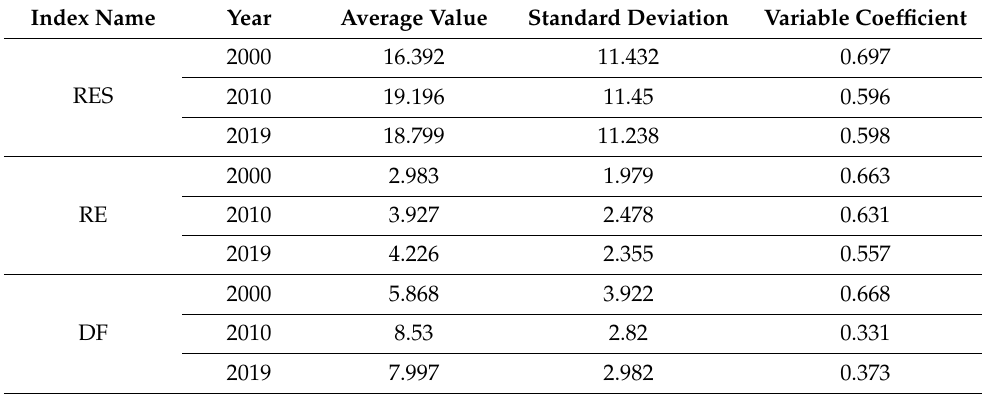
Figure 7. Spatial Pattern ( Left ) and Local Spatial Cluster ( Right ) Map of the Economic Security of Prefecture-level Cities in the Qinghai–Tibet Plateau. Table 5. Average, Standard Deviation and Coefficient of Variation of Economic Security and its Fractal Dimension Indexes of Prefecture-level